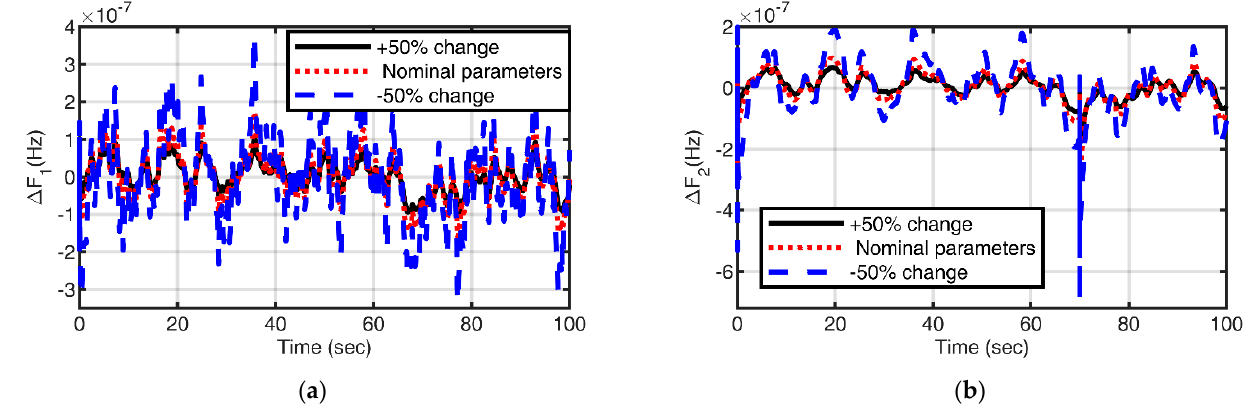
Figure 14. ( a ) Frequency response of area 1. ( b ) Frequency response of area 2.